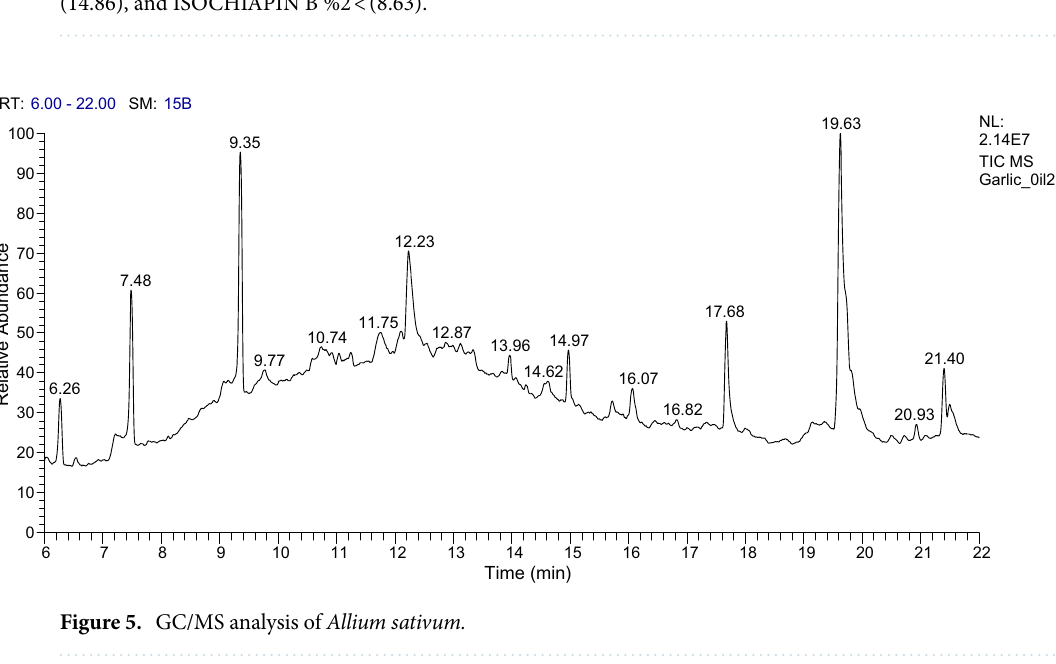
Table 11. GC/MS analysis of the Allium sativum. 9-Octadecenamide, (Z)- (29.07), Trisulfide, di-2-propenyl (14.86), and ISOCHIAPIN B %2 < (8.63).